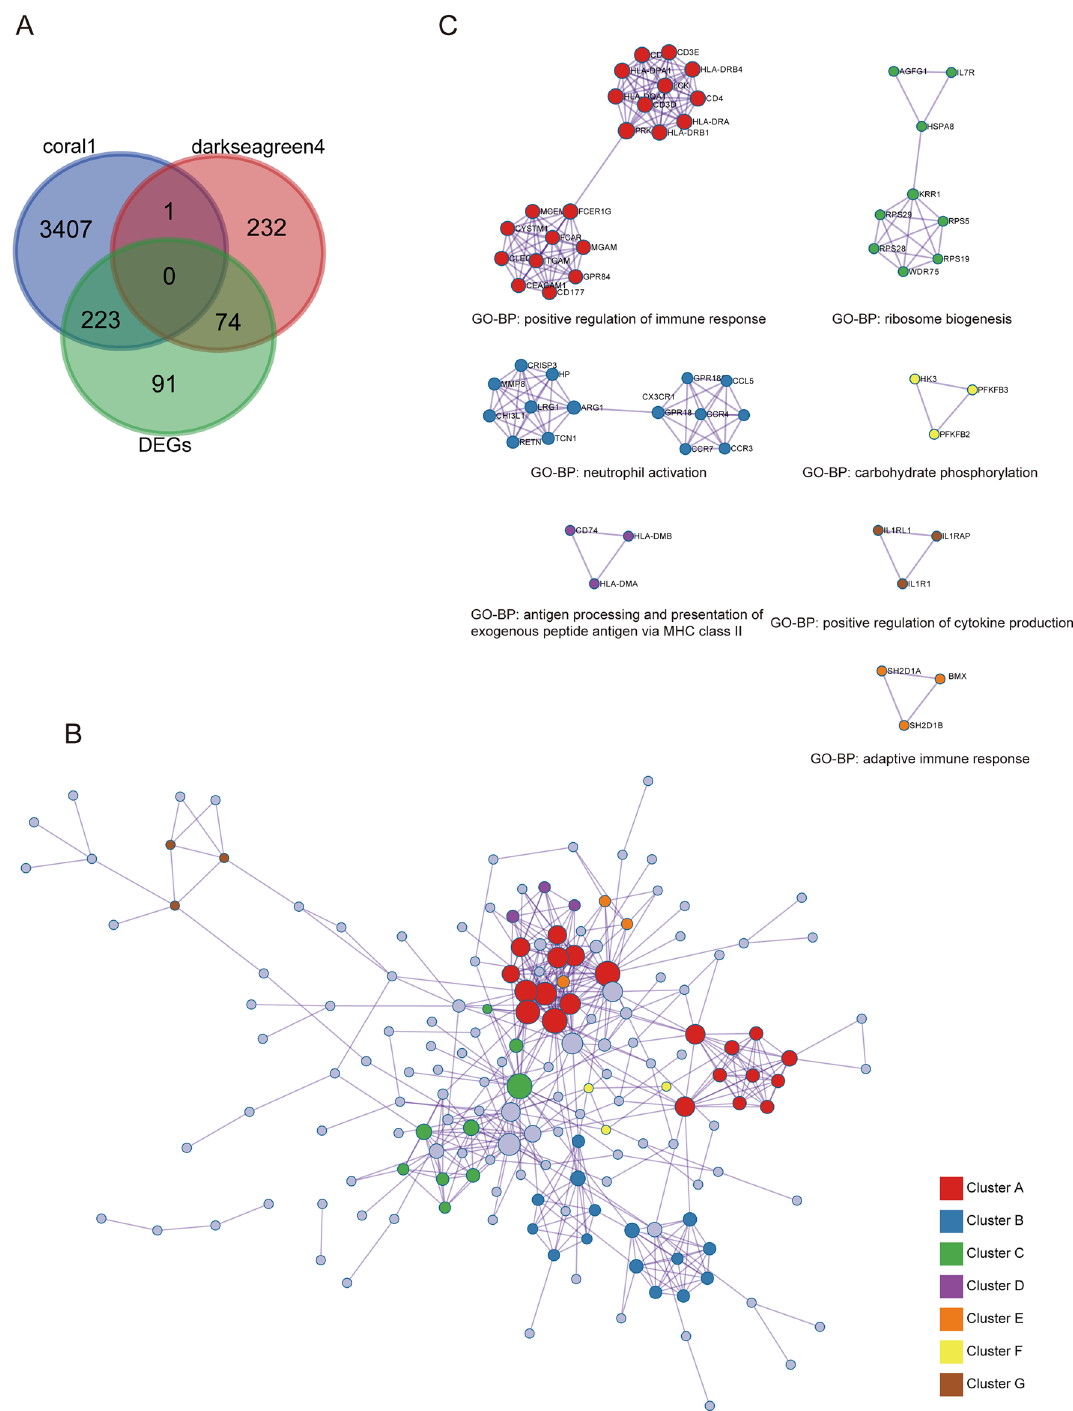
Figure 9. Acquisition of immune-related DEGs and construction of PPI networks. ( A ) The Venn diagram shows 297 DEGs overlapping with immune-related gene modules. ( B ) PPI network of 297 immune-related DEGs. ( C ) Seven clusters in the PPI network are described with